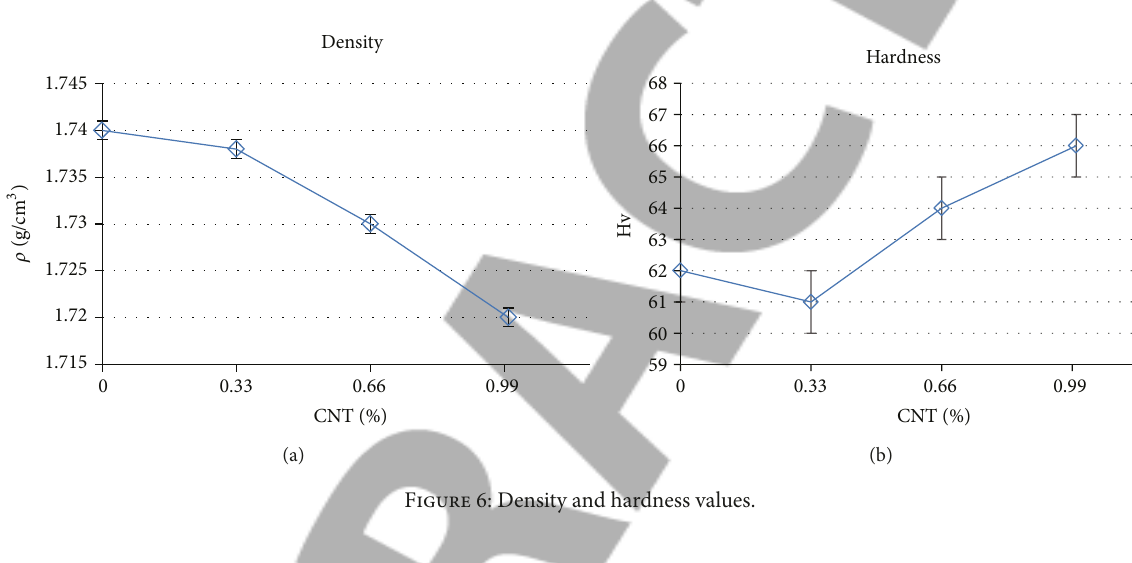
Figure 6: Density and hardness